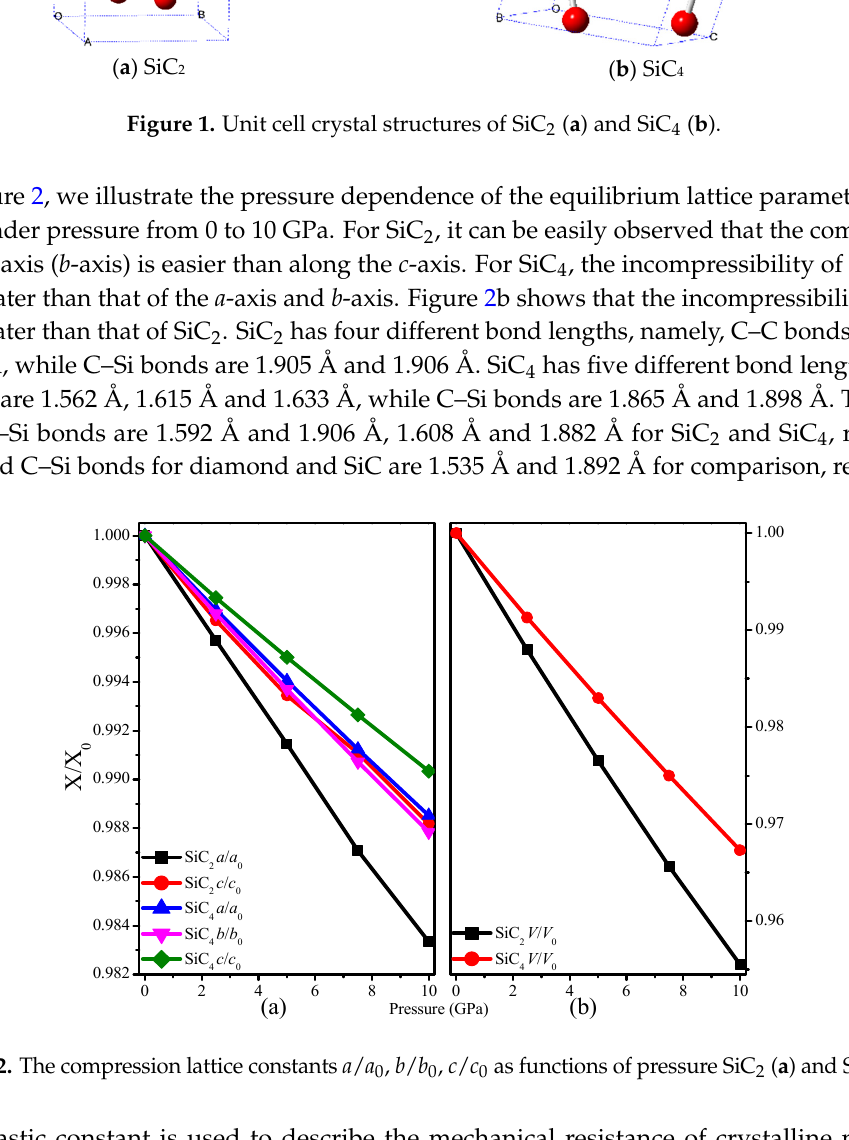
Figure 2. The compression lattice constants a / a 0 , b / b 0 , c / c 0 as functions of pressure SiC 2 ( a ) and SiC 4 ( b ).